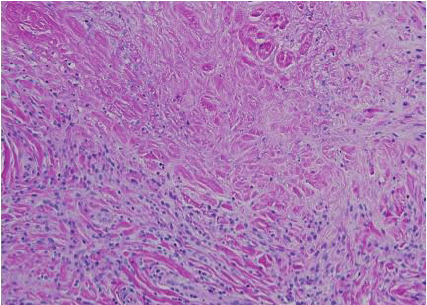
Figure4:Histopathologicalevaluationofanoduleontherighthand (20x) shows a perivascular and interstitial infiltrate of lymphocytes andhistiocytessurroundingareasofdegeneratedcollagenandfibrin with mucin